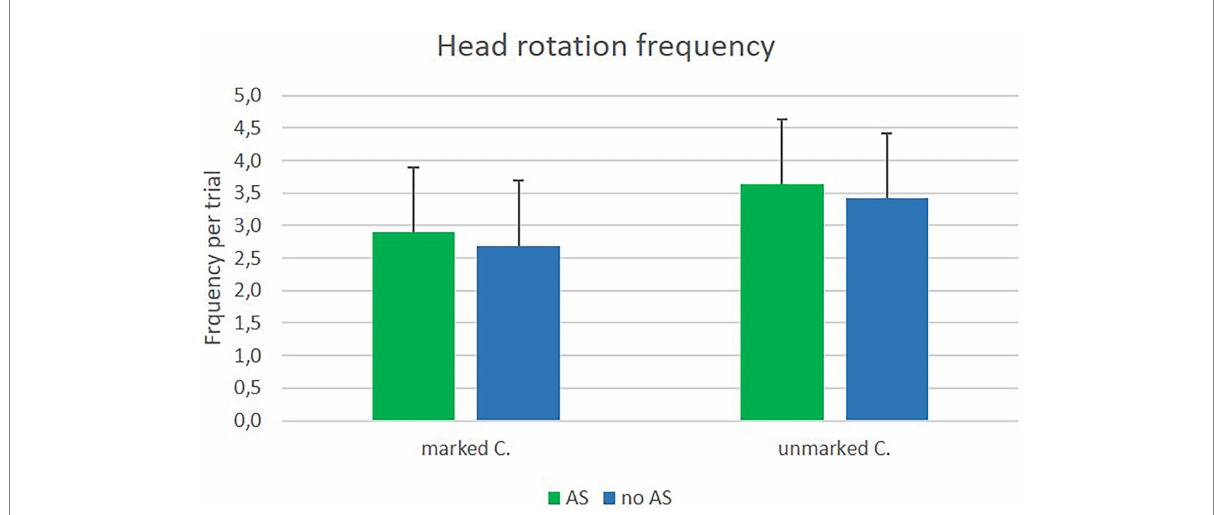
FIGURE 9 Means of head rotation frequencies in the field experiment at marked and unmarked crossings with (AS) and without (nAS) assistance system.